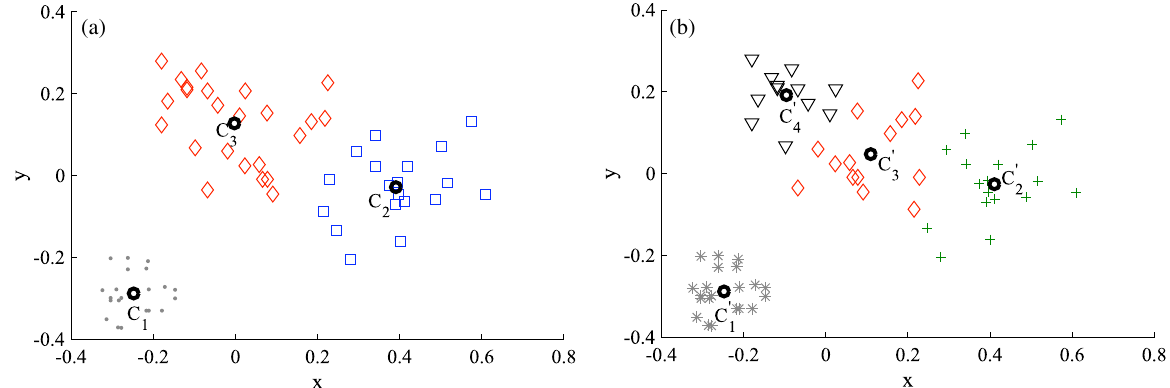
FIG. 3. Clustering of N ¼ 64 hypothetical data using the k -means method for (a) q ¼ 3 clusters and (b) q ¼ 4